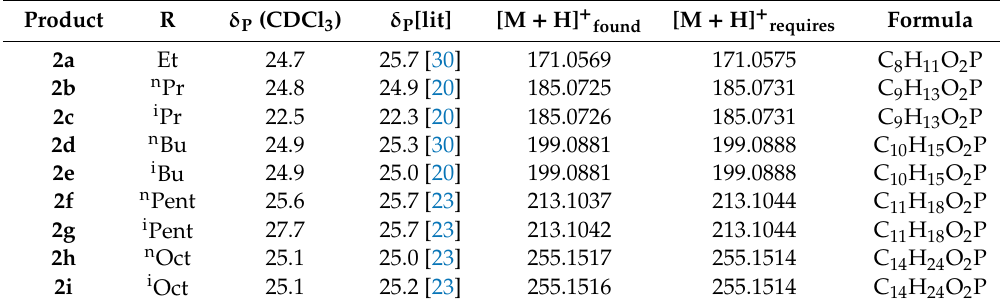
Table 8. 31 P-NMR and HRMS data for phosphinates 2